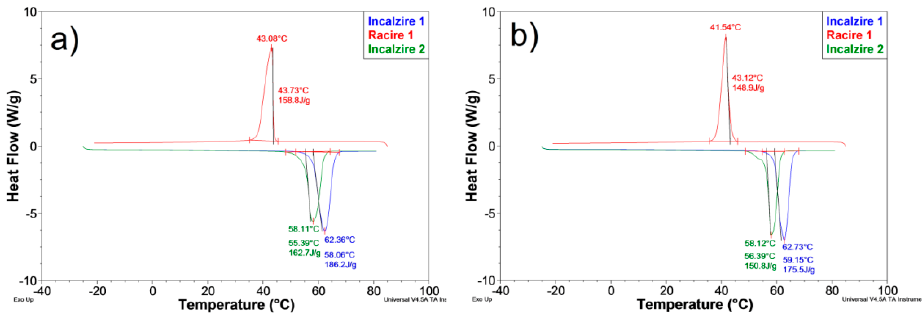
Figure 1. DSC curves of mixtures of PEG 4000 –Si with ( a ) PEG 4000 and ( b ) PEG 6000 at a 1:1 ratio